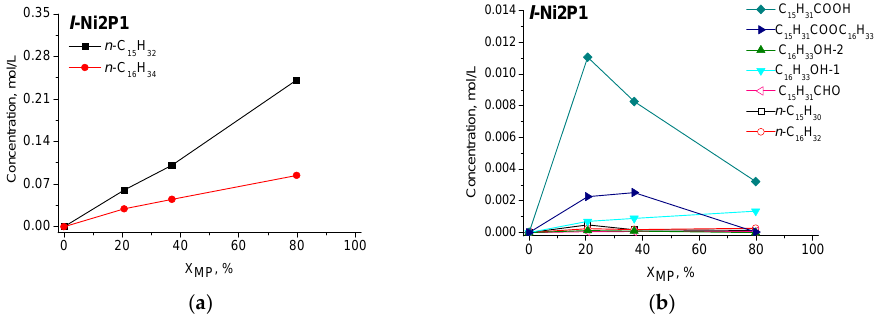
Figure 6. Concentration profiles of liquid ‐ phase components during methyl palmitate HDO over l ‐ Ni2P1 catalyst: ( a ) the main products—C 15 and C 16 hydrocarbons; ( b ) the observed intermediates. Reaction conditions: P H2 = 3.0 MPa, T = 290 °C, H 2 /feed = 600 Nm 3 /Nm 3 , LHSV = 0.3–1.5 h − 1 . Catalysts 2017 , 7 , 298